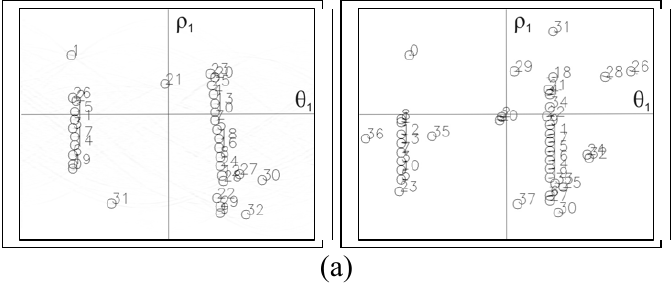
Figure 6. Lines detected using the local maximum search. (a) Local maximums (b) Detected